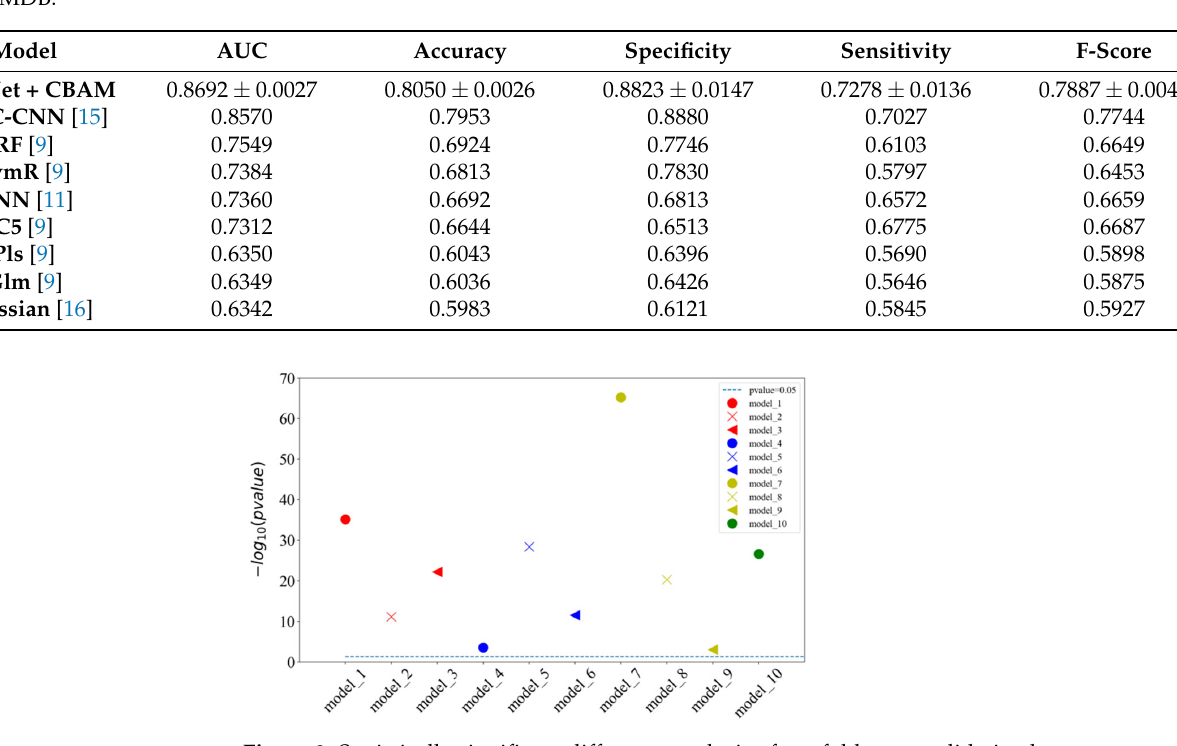
Figure 3. Statistically significant difference analysis of ten ‐ fold cross ‐ validation between our model and 1D ‐ 2C ‐ CNN method. Model_1,model_2,…,model_10 are the models of CapsNet + CBAM